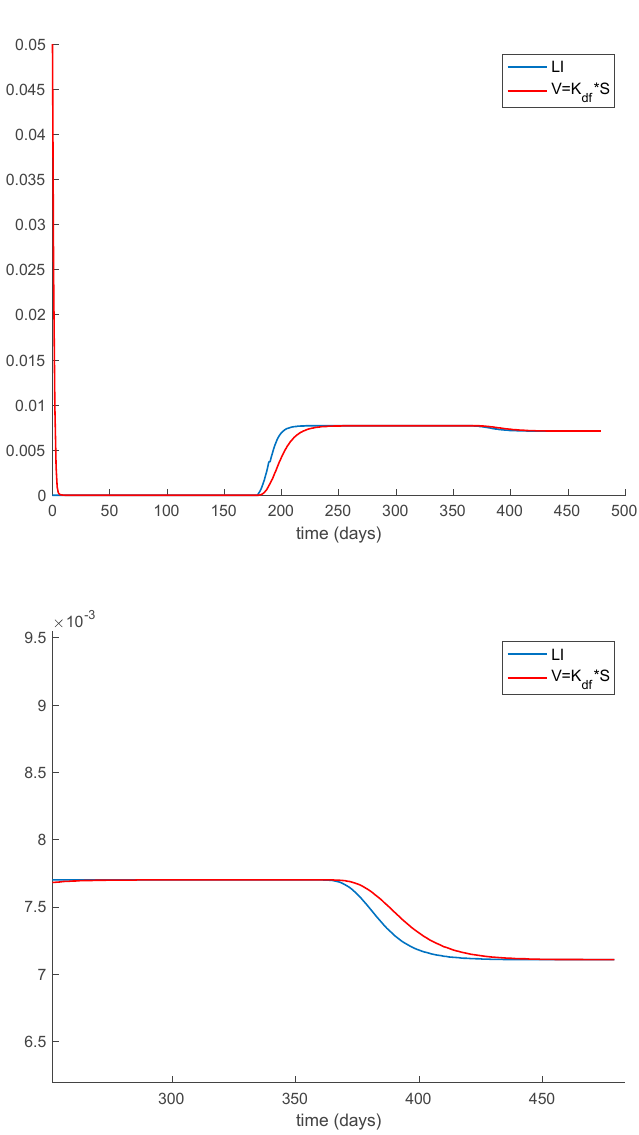
Figure 14. Condition to guarantee the global asymptotic stability of the disease-free equilibrium point for Case 1.7.